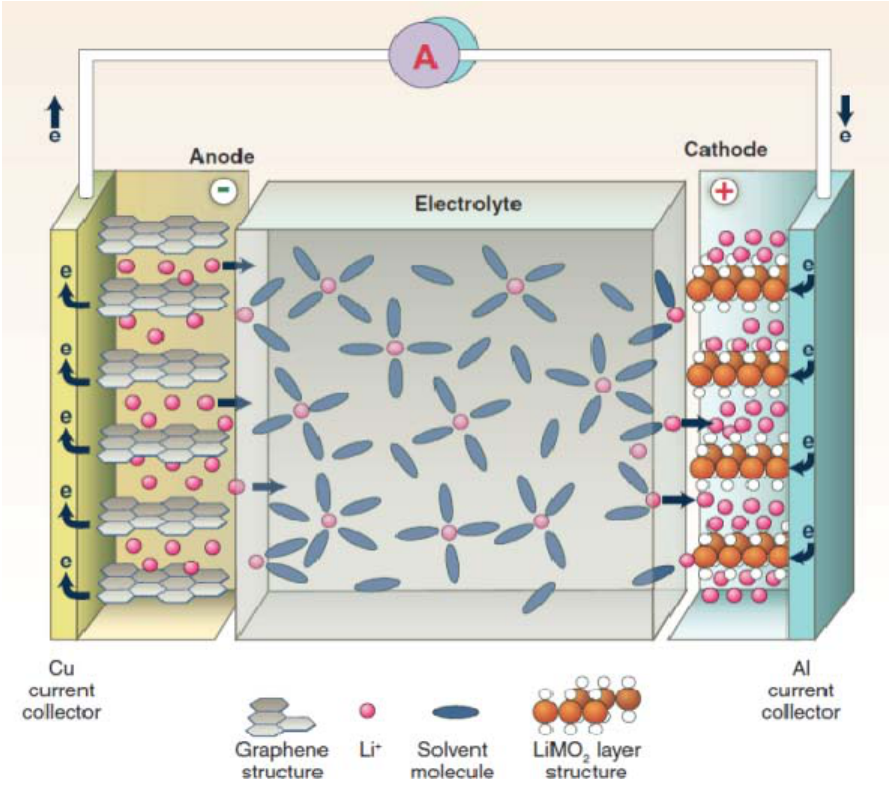
Figure 2. Schematic of a lithium ion battery (LIB) consisting of the negative electrode (graphitic carbon) and positive electrode (Li-intercalation compound)